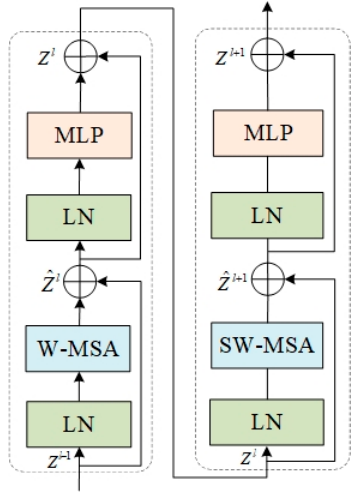
Figure 7. Swin Transformer Block.